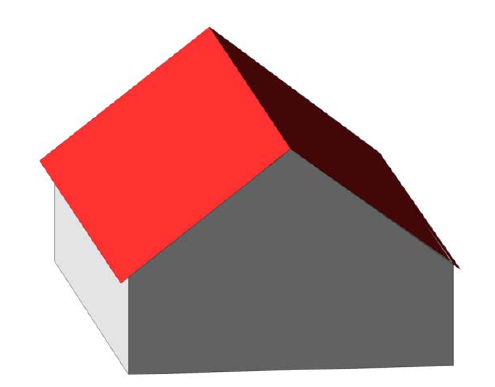
Figure 5. Possible combination of both